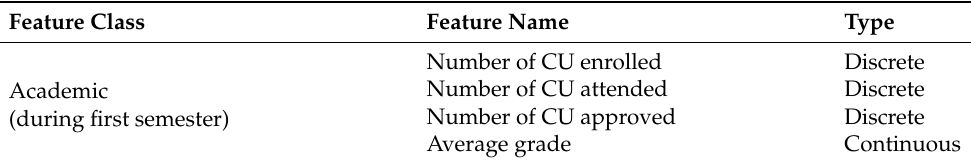
Table 2. Summary of additional features for the dataset S1. Additional features for dataset S2 represent the same information but for the second semester. CU: Curricular